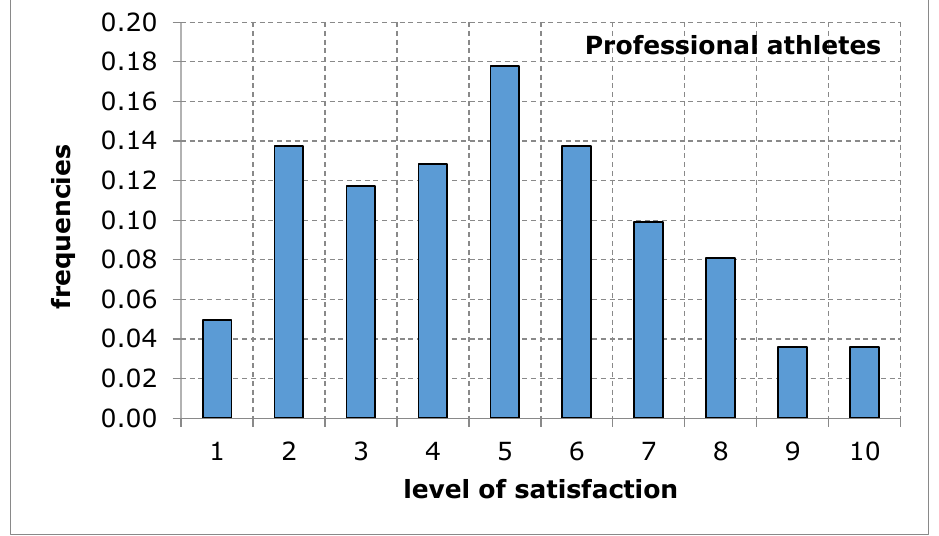
Figure 12. Lack of preferred sport and recreational activities at a sports and recreation facility, in the opinion of service recipients (professional athletes). Source: own work.